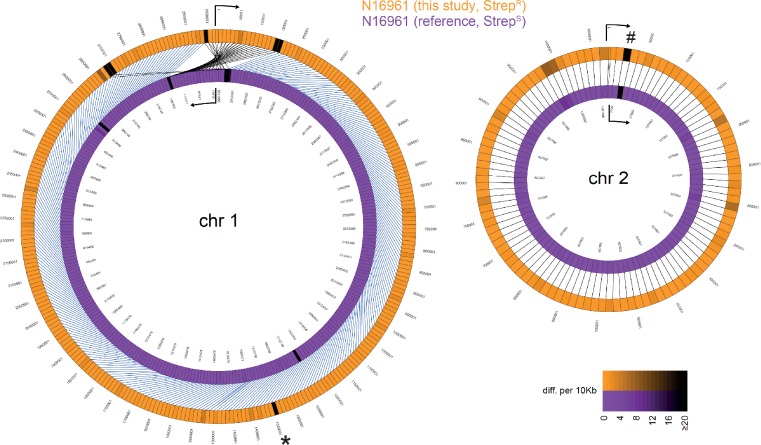
Comparative genomics of V. cholerae reference strain N16961 and a newly sequenced laboratory stock of the same strain.The newly sequenced genome of the streptomycin-resistant laboratory stock of strain N16961 (long-read PacBio sequencing technology; Matthey et al., 2018) was compared to the genome sequence of the reference genome (Heidelberg et al., 2000). Detailed explanations on the comparison are as described for Figure 2. The shadings (for both colors) reflect differences (SNP or indel) from 0 to ≥20 per 10 kbp fragment. Marked discrepancies are based on repetitive sequences (*) or a sequencing error (#) as discussed in the Materials and methods section.